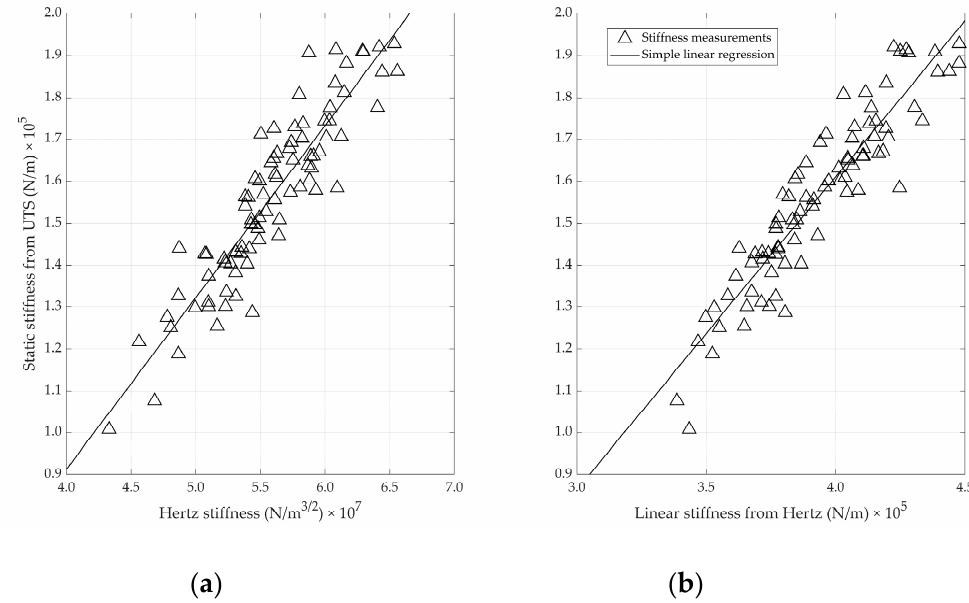
Figure 5. ( a ) Relation between the static stiffness measured during quasi-static compression and Hertz stiffness, ( b ) and a linear stiffness derived from impact measurements.